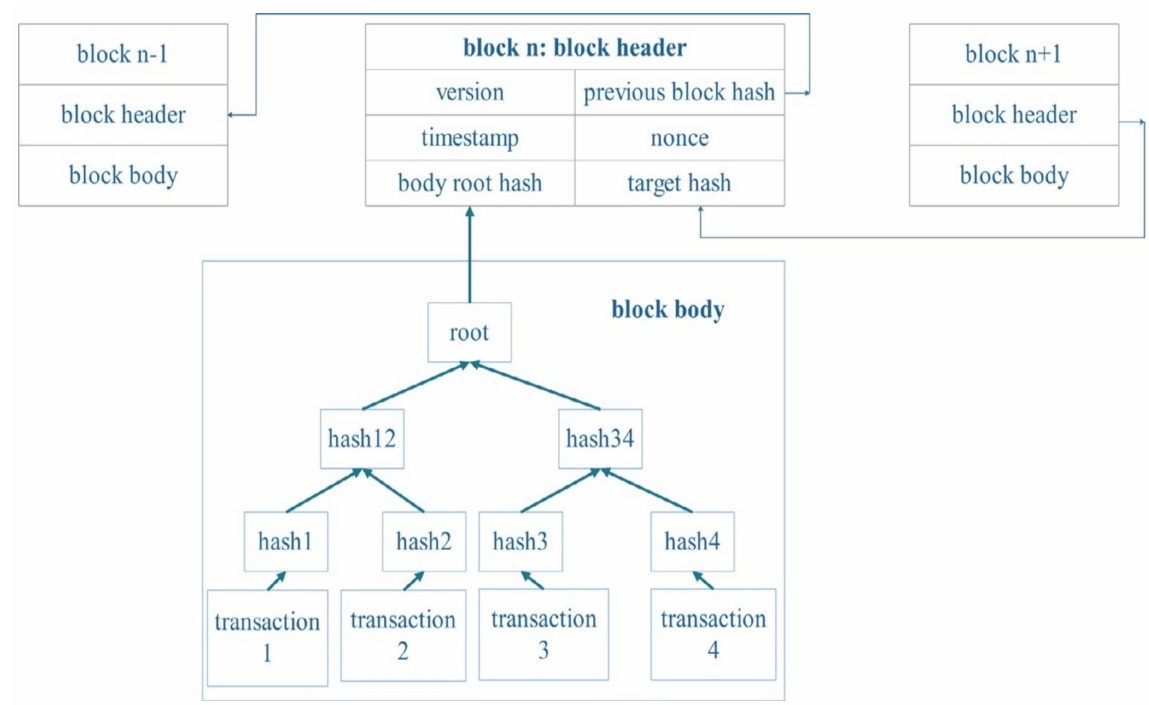
Figure 2. Block structure